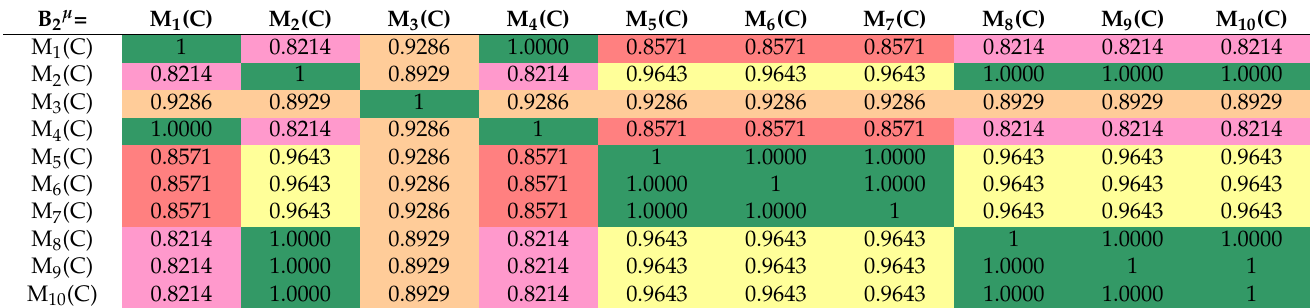
Table 7. Table 7. Index matrix B 2 µ for oxygen